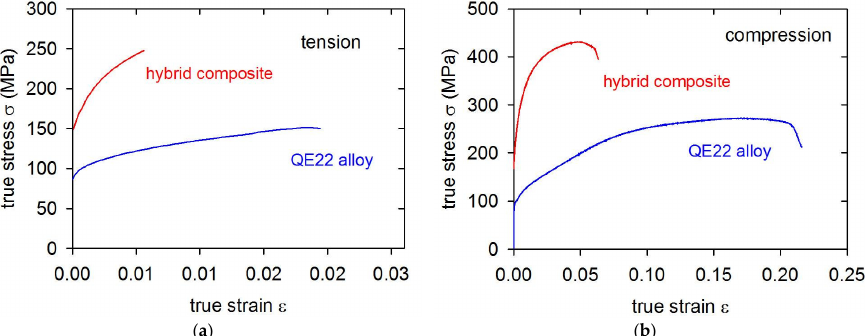
Figure 4. True stress–true strain curves of the QE22 matrix alloy and the hybrid composite in tension ( a ) and compression ( b ). Table 2. Characteristic stresses and the strain-to-fracture ratio obtained in tension and compression.